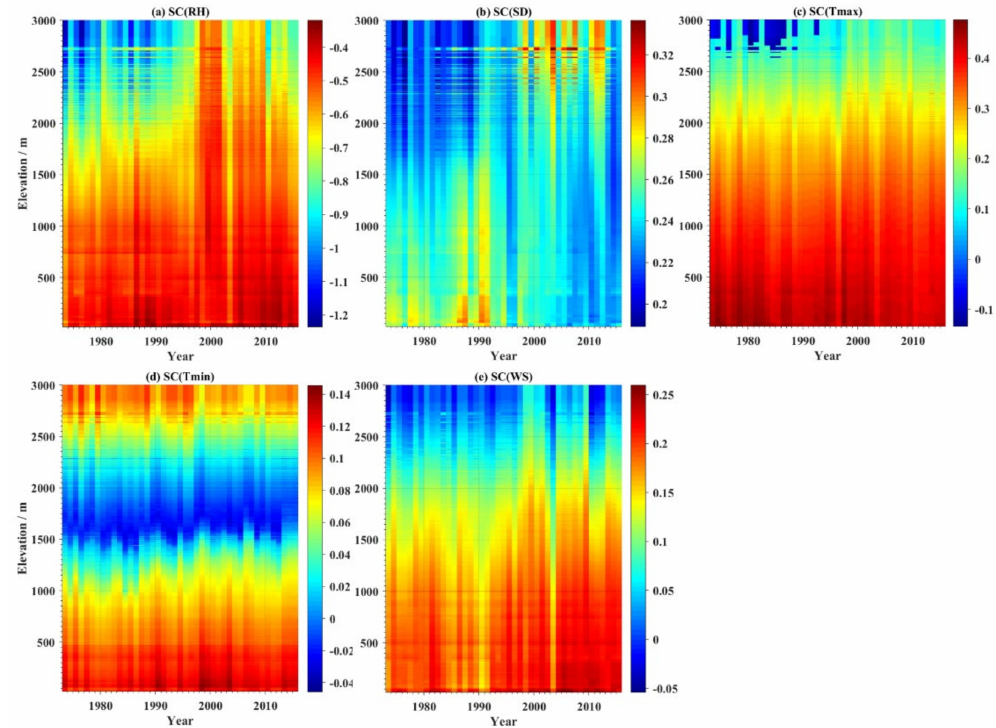
Figure 10. The changes in the sensitivity coefficients of the five climatic factors along the elevation gradients across the THM during 1973–2016. ( a ) SC(RH), ( b ) SC(SD), ( c ) SC(Tmax), ( d ) SC(Tmin), ( e )